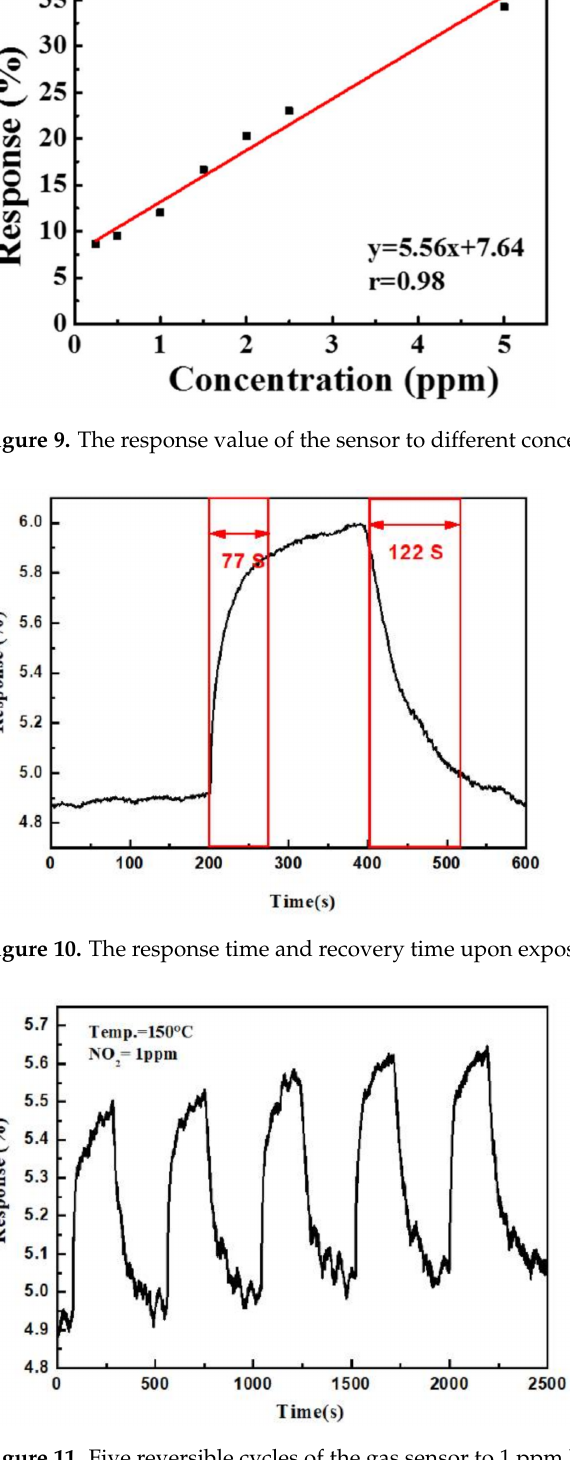
Figure 11. Five reversible cycles of the gas sensor to 1 ppm NO 2 at 150 ◦